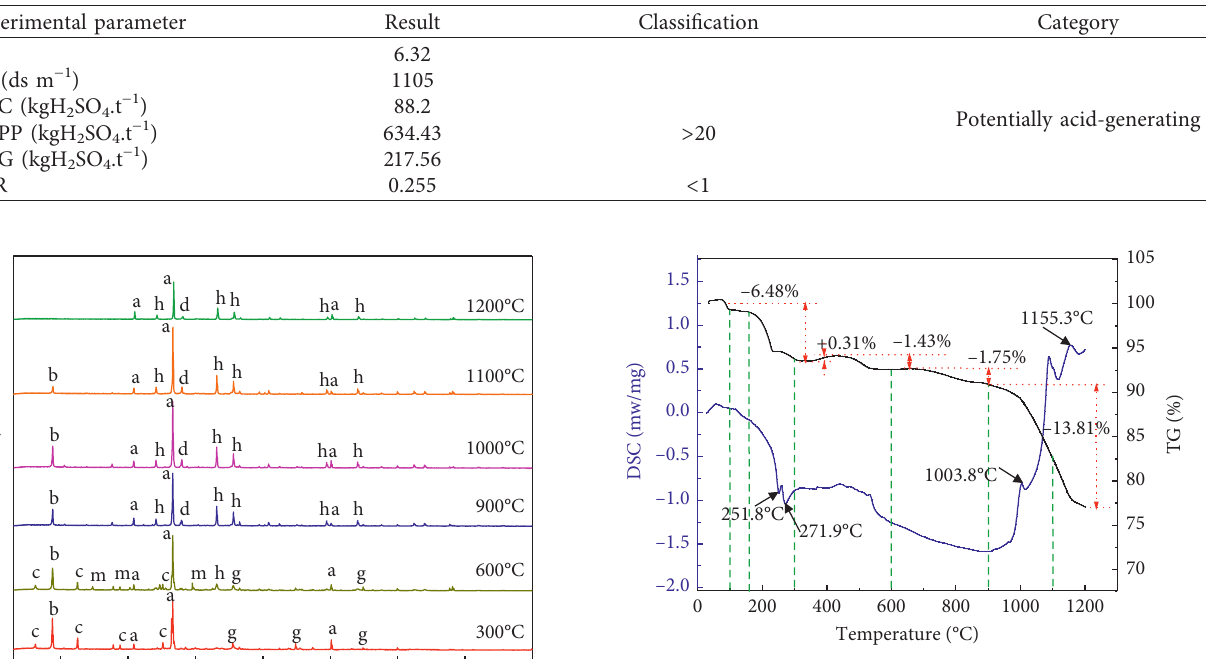
Table 2: Acid-producing potential of the copper tailings.